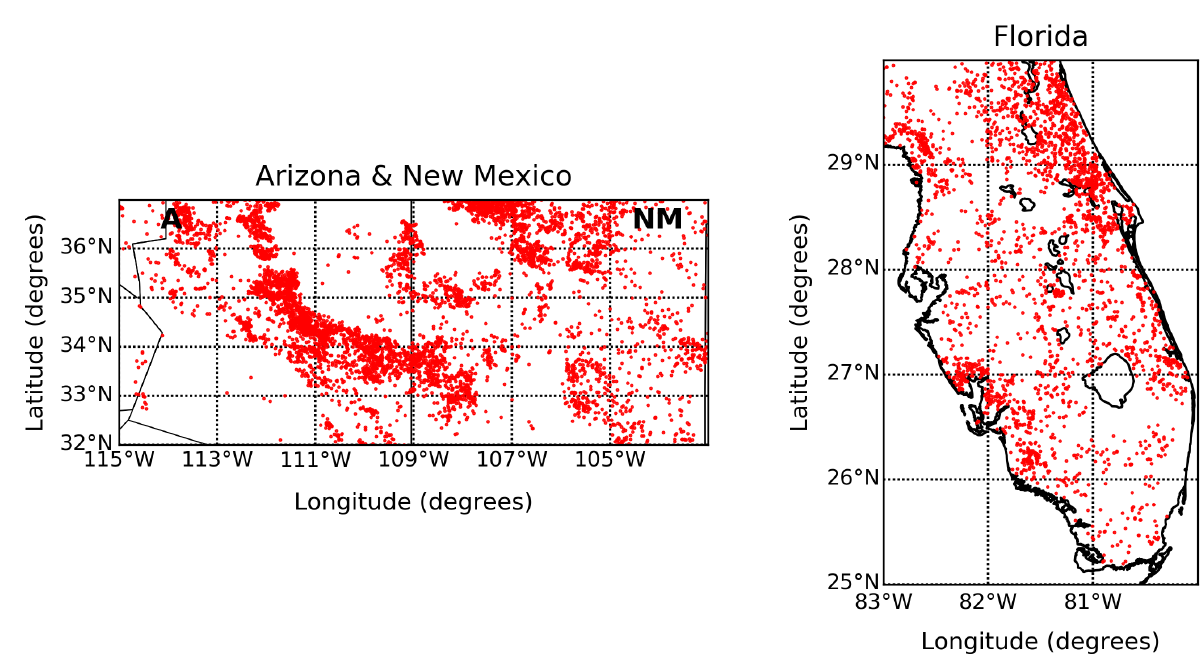
Figure 1. Lightning-ignited Wildfires (LIW) (red dots) between 2009 and 2013 included in this study for Arizona and New Mexico ( left ) and for Florida ( right